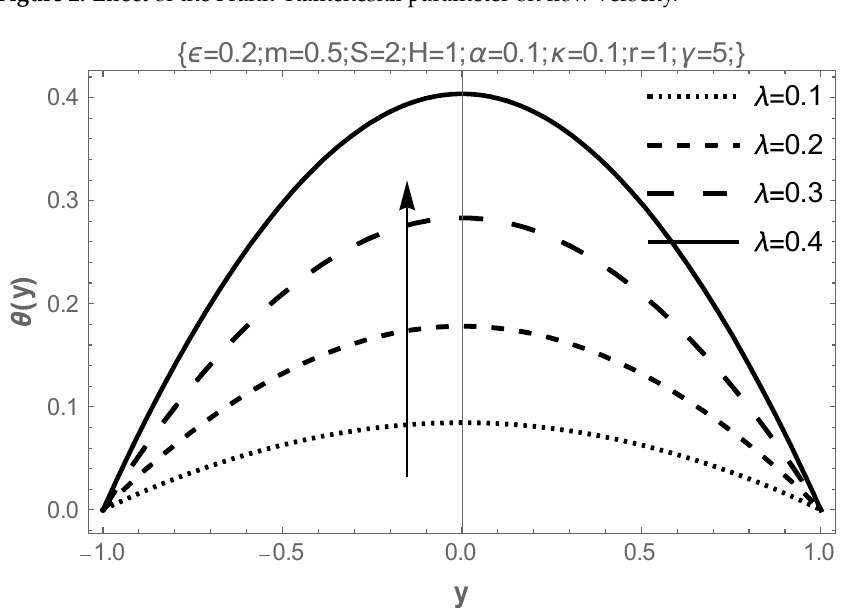
Figure 3. Effect of the Frank–Kameneskii parameter on fluid temperature.